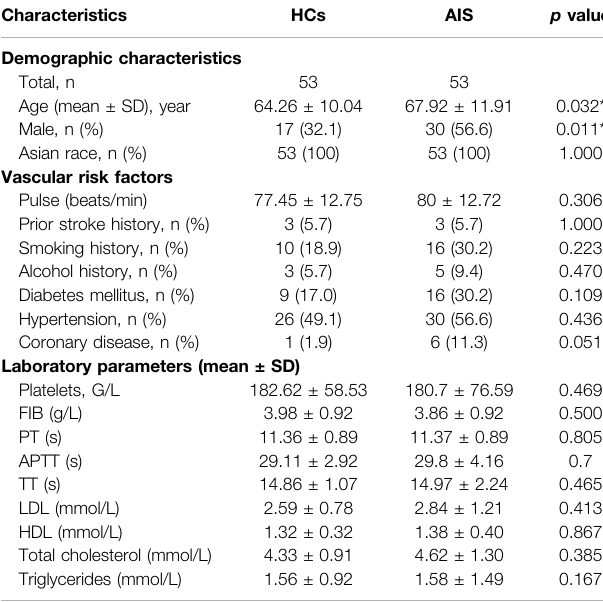
TABLE 1 | Demographic and clinical characteristics of healthy control subjects and AIS samples.